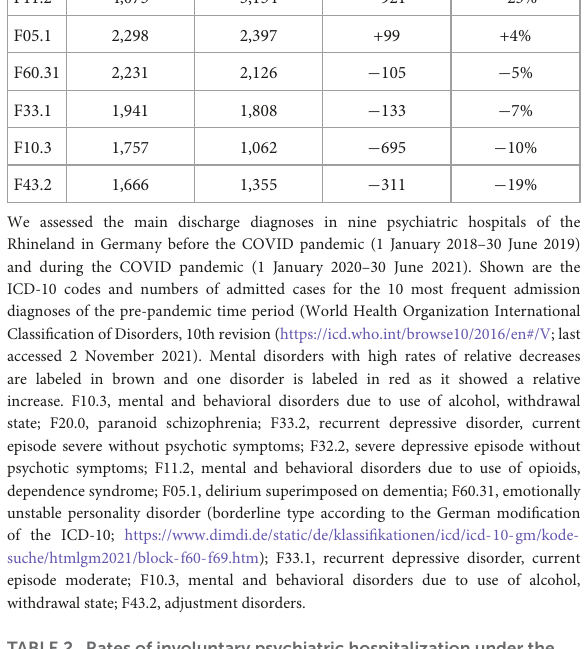
TABLE 2 Rates of involuntary psychiatric hospitalization under the auspices of the Mental Health Act (Psych KG NRW) and rates of coercive measures in the nine LVR psychiatric